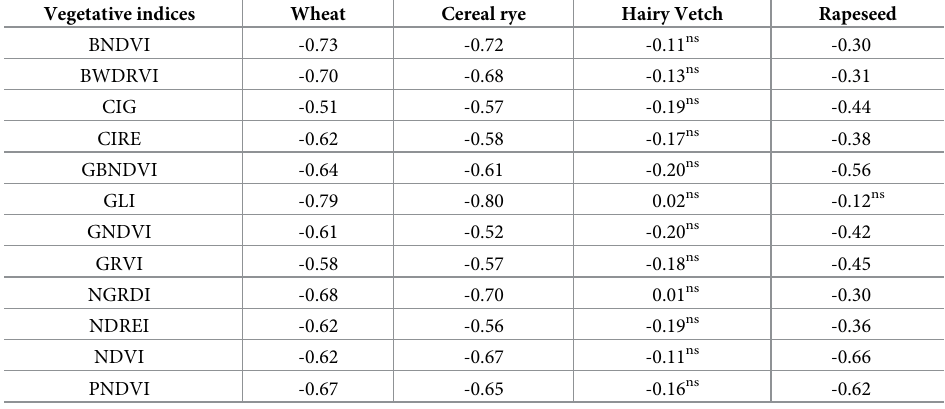
Table 7. Value of Pearson correlation coefficient between termination efficiency and vegetative indices for respec- tive cover crop species.